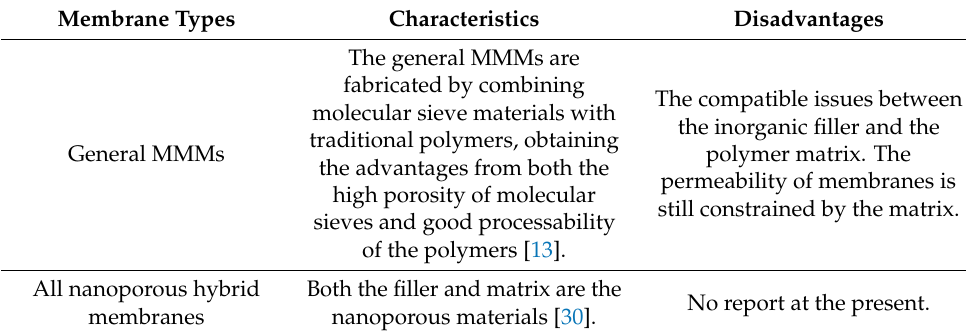
Table 8. Characteristics of mixed matrix membranes (MMMs) used for C 3 H 6 /C 3 H 8 separation.